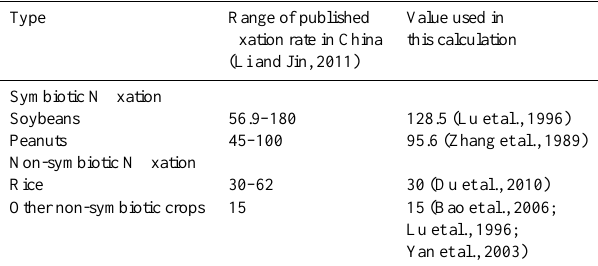
Table 1. Biofixation rate and values used for calculating N